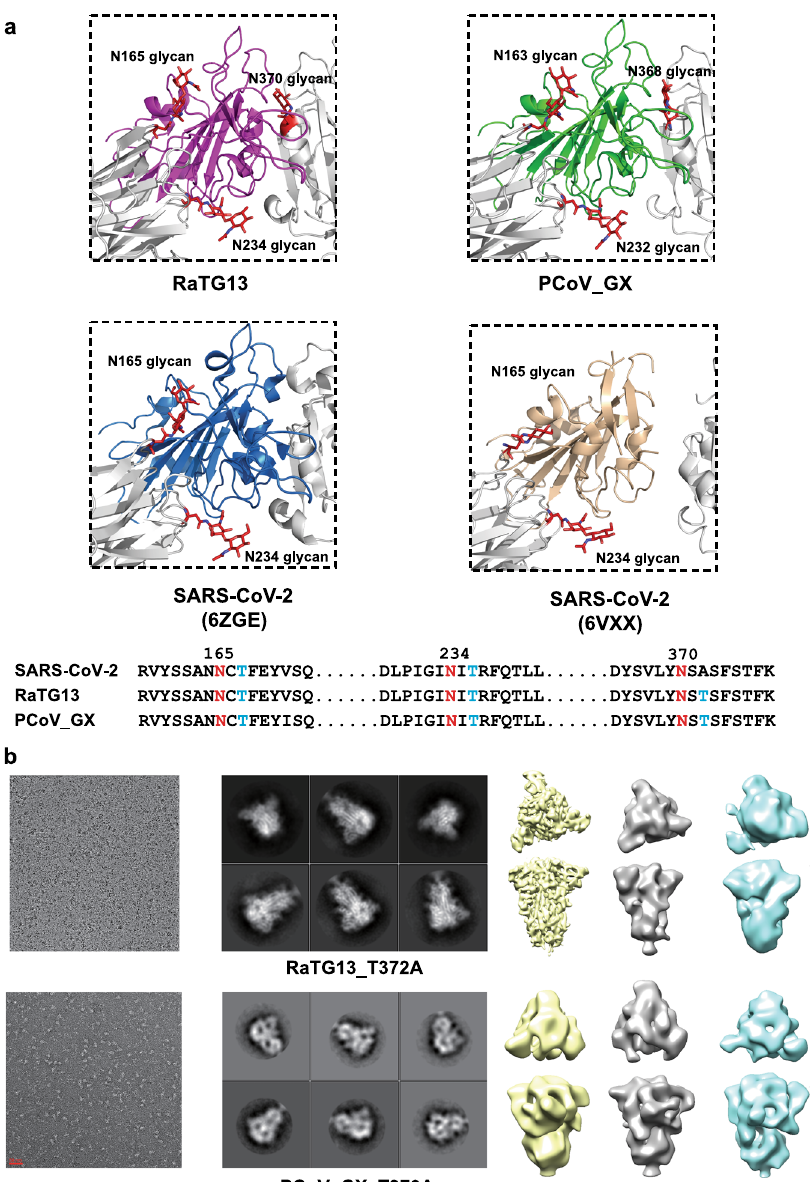
Fig. 3 RBD-contacting glycans in the RaTG13 and PCoV_GX spikes. a Detailed structures of the RBD-glycans interface are shown. The RaTG13 RBD is colored in magenta, PCoV_GX RBD in green, SARS-CoV-2 (PDB ID: 6VXX) RBD in wheat, and SARS-CoV-2 (PDB ID: 6ZGE) RBD in marine; remaining regions shown in gray. Glycans are shown as red sticks and labeled. Sequence alignment of the SARS-CoV-2, RaTG13 and PCoV_GX RBD-contacting glycosylation sites is shown in the bottom panel. Sequences between the three sites are omitted and indicated by black dots. Amino acid positions of asparagines are indicated above the sequences according to SARS-CoV-2. Asparagines (N) are colored red and threonines (T) are colored blue. b Cryo-EM analysis of the RaTG13_T372A and negative-staining EM analysis of the PCoV_GX_T370A. The representative micrographs, 2D classi fi cation and 3D classi fi cation results were